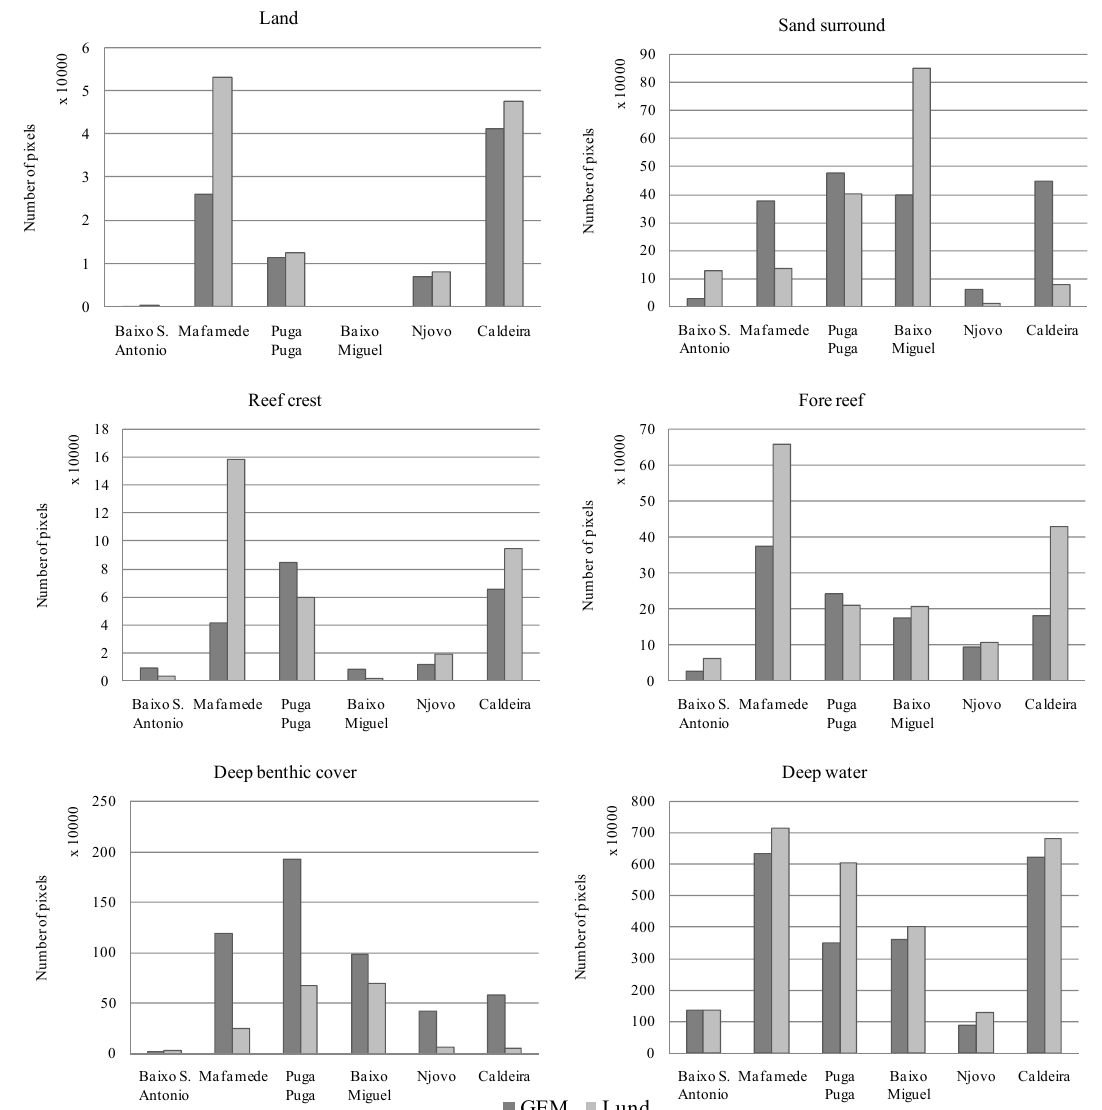
Figure 5. Paired class comparison across the different coral reef systems at the geomorphological level; GEM refers to the pixel based mapping products, and Lund to the OBIA mapping.